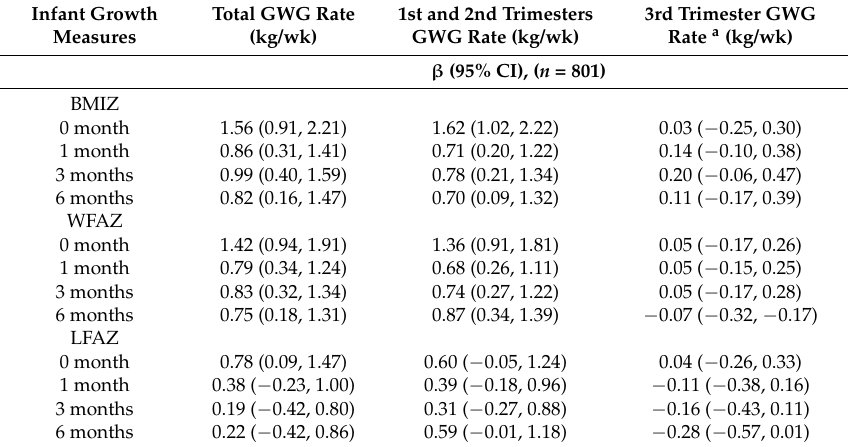
Table 3. Associations of total and trimester-specific gestational weight gain rate with infant growth measures at birth, 1 month, 3 months, and 6 months among 801 mother–infant pairs in Born in Shenyang